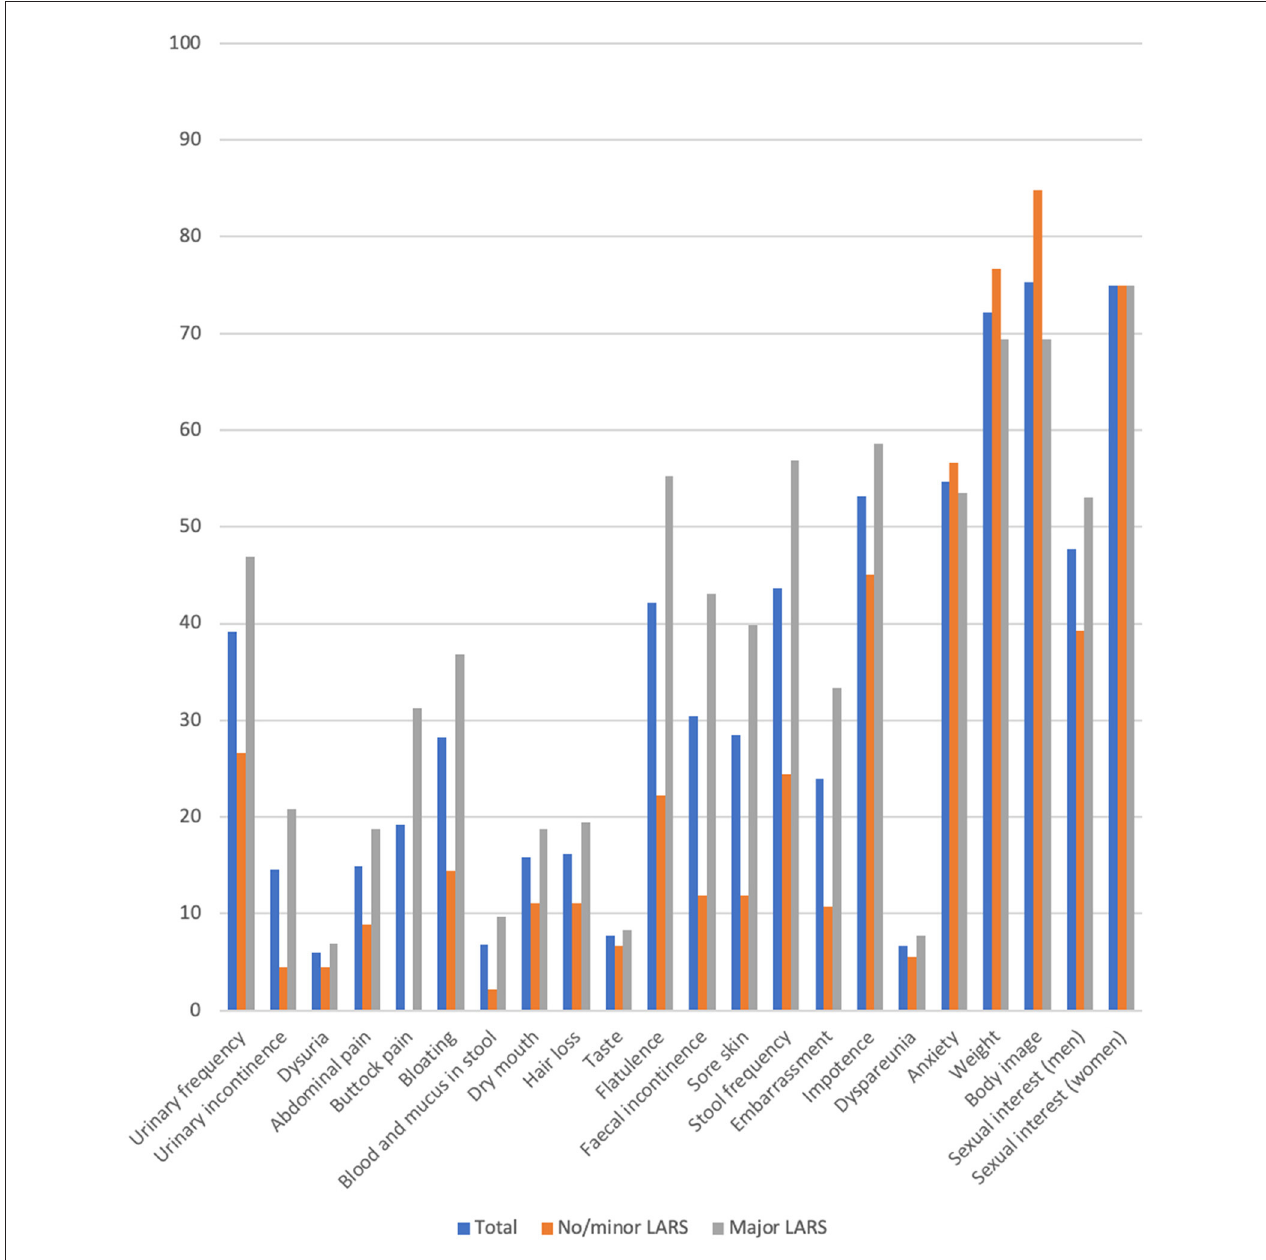
FIGURE 4 | Results of the QLQ-CR 29 questionnaire comparing no/minor with major LARS (mean). Scoring according to the EORTC-scoring manual a high score in fuctional scales represents a high functional level wehreas a high score in symptom scales correlate with a high level of symptoms.